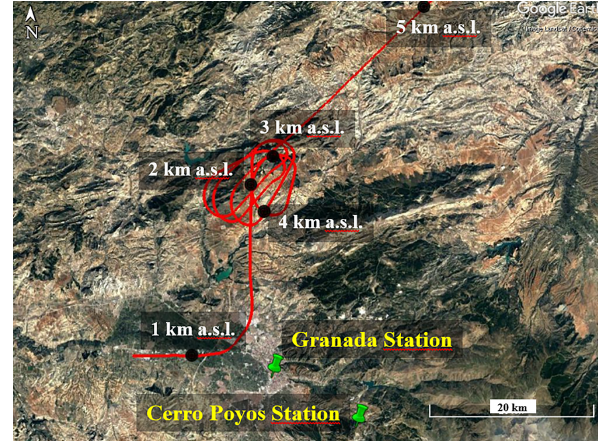
Figure 1. Map illustrating the Granada and Cerro Poyos stations. The red line indicates the trajectory and the black points show the altitude of the aircraft on 17